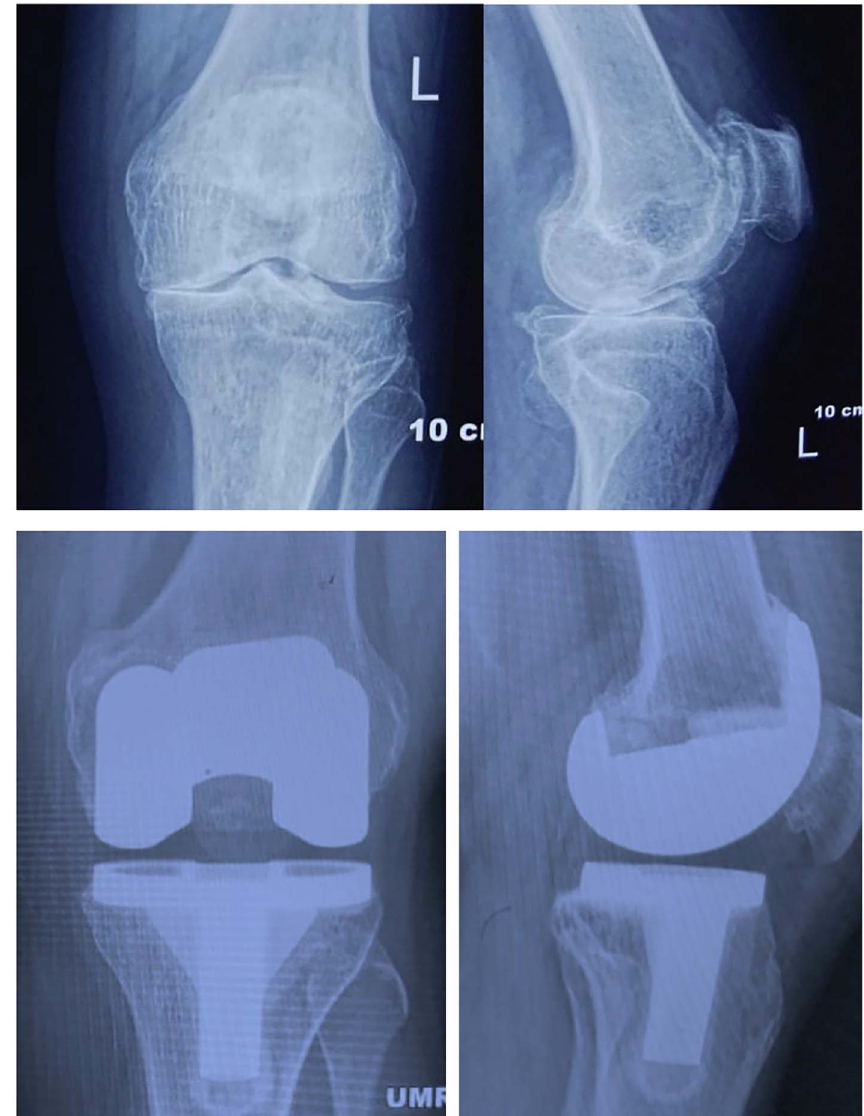
Figure 3. Pre- and Post-operative radiographs of TKA (PFC Sigma-PS) for medial OA of the knee.